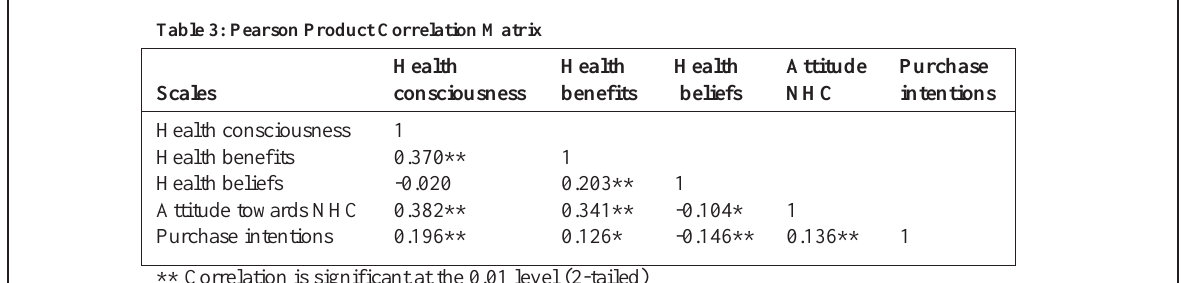
ANOVA sig. values